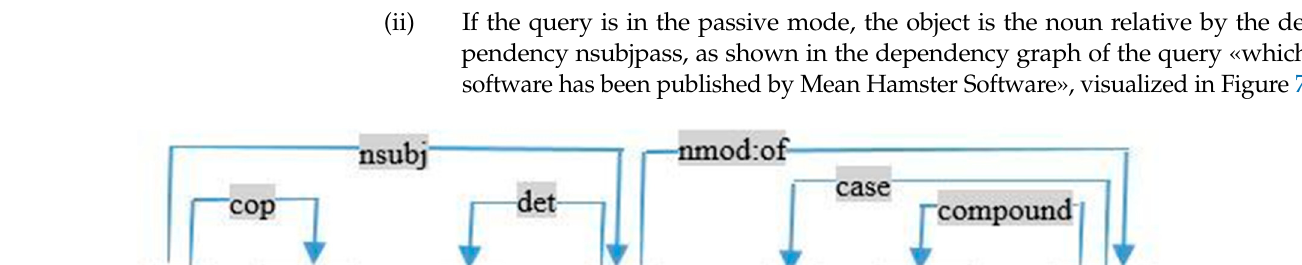
Figure 6. Graph dependency of the query «what is the profession of Frank Herbert».